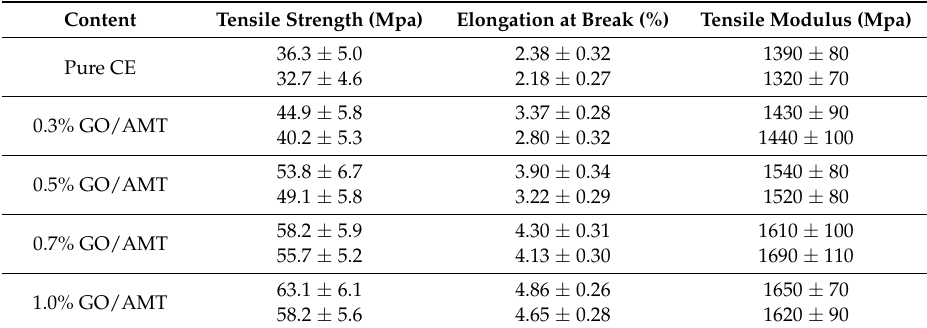
Table 2. The mechanical properties of the dried and wet (upper and lower row, respectively for each material) CE resins modified by GO/AMT.